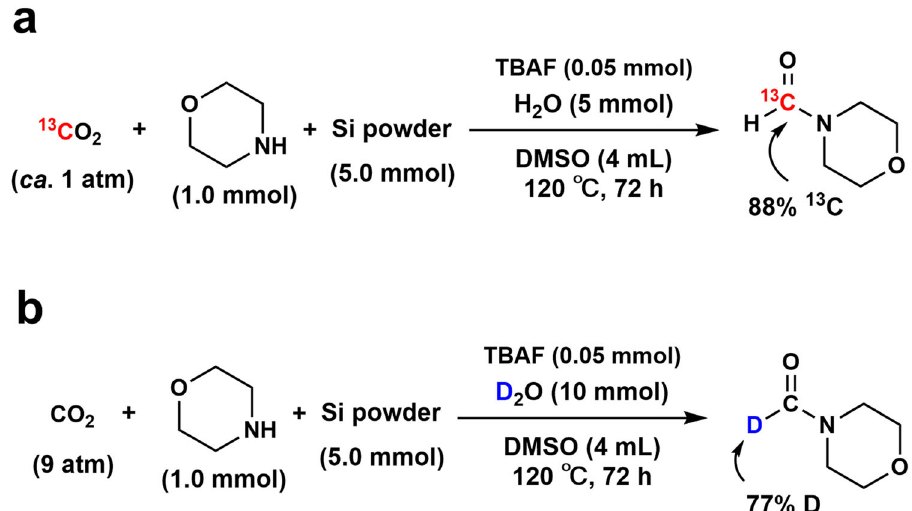
Fig. 3 Isotopic experiment of fl uoride-catalyzed CO 2 conversion to formamide. The reaction using ( a ) 13 CO 2 and ( b ) D 2 O instead of 12 CO 2 and H 2 O, respectively.